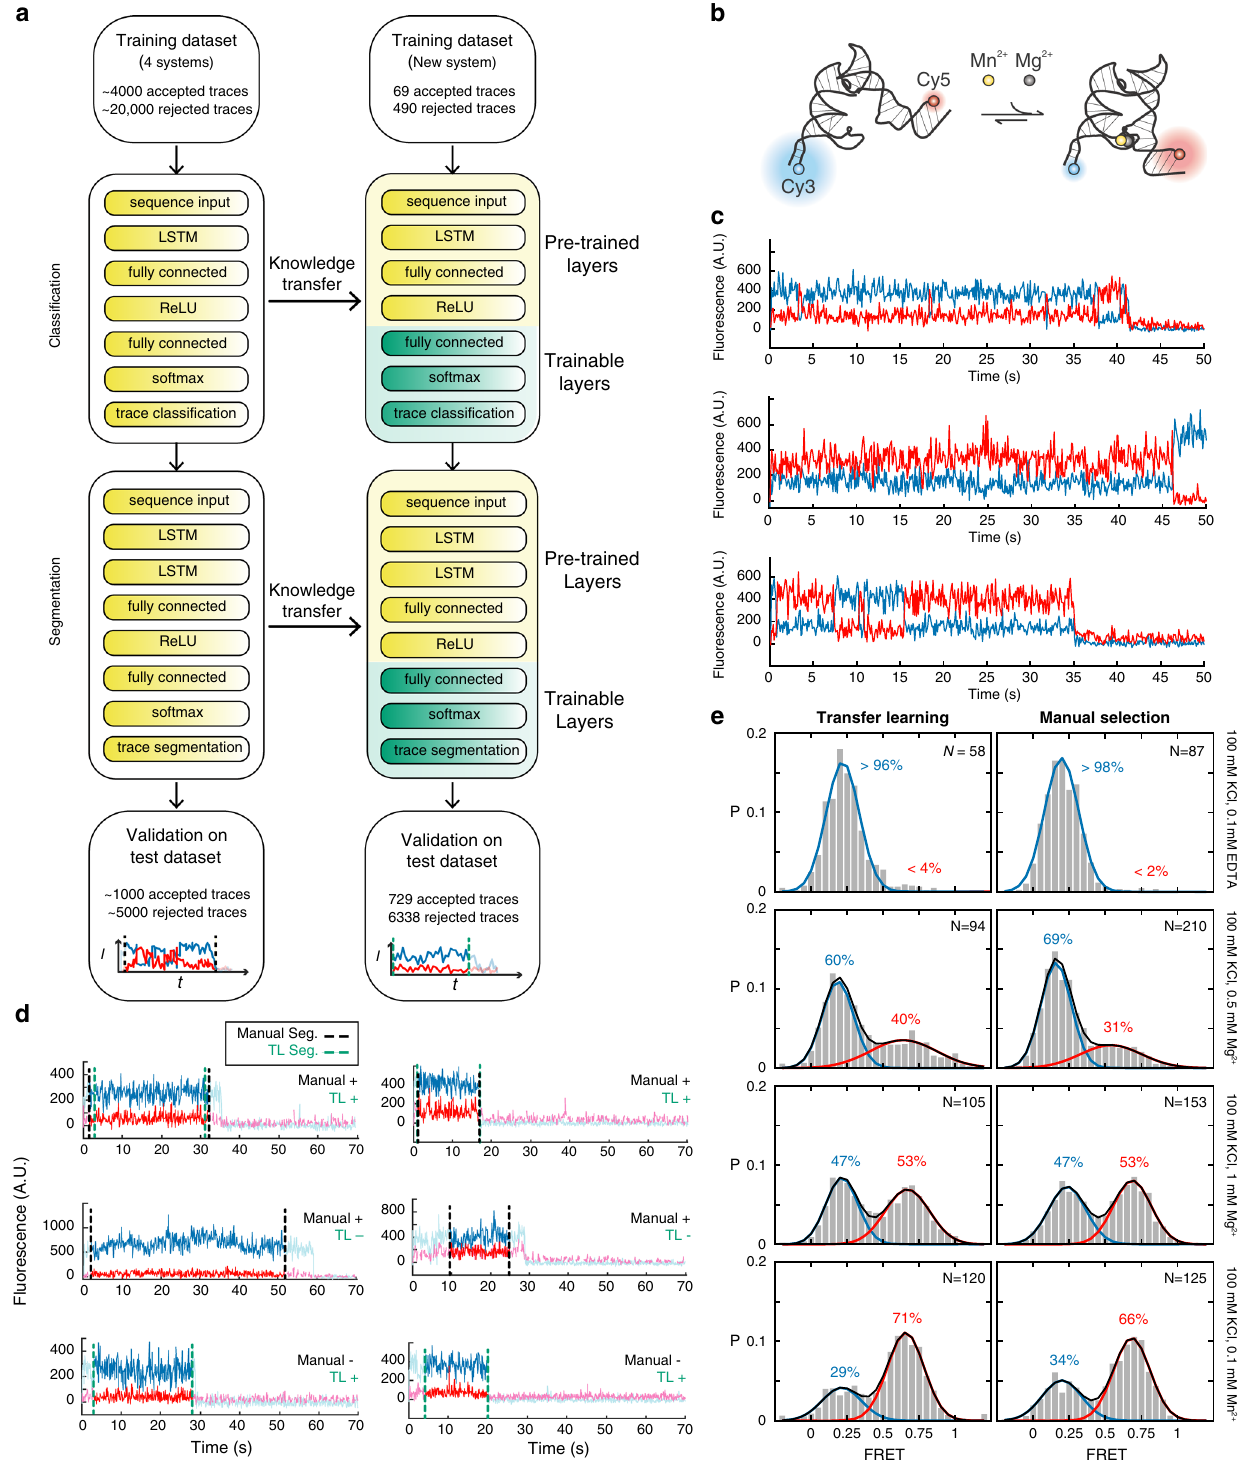
Fig. 4 Adaptation of previously trained networks to a novel smFRET system with Transfer Learning by AutoSiM. a Schematic depiction of TL. Networks previously trained on a large database of smFRET traces are adapted to a new system by retraining only the fi nal layers of each network using a small training set from the new experimental system. b Schematic of a previously characterized Mn 2 + riboswitch system 42 that is used here as a test case for TL, since data from this system were not present in the original training set for the LSTM networks. c Three representative time traces from the Mn 2 + riboswitch system illustrating its diverse molecular behaviors: static low-FRET (top), static high-FRET (middle), and dynamic (bottom). d Representative traces illustrating True Positive, False Negative, and False Positive classi fi cation and segmentation results from TL. e FRET histograms for the Mn 2 + riboswitch following classi fi cation and segmentation by TL or manual selection, with two-peak Gaussian fi ts and corresponding population estimates for the low- and high-FRET states. The number of traces (N) included is shown in the upper right corner of each